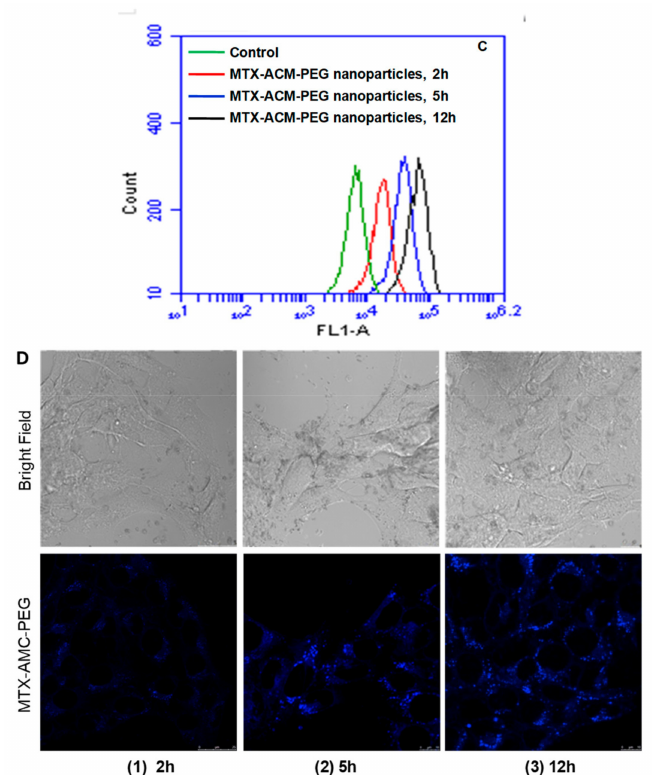
Figure 4. The cytotoxicity of MTX-AMC-PEG nanoparticles to 4T1 breast cancer cells, ( A ) cell viability of 4T1 cancer cells incubated with MTX-AMC-PEG nanoparticles for 48 h; ( B ) cell viability of 4T1 cancer cells incubated with MTX-AMC-PEG nanoparticles (0.4 µ g / mL) under 365 nm (5 W) for 0, 0.5, 1.0, 2.0, and 3.0 min. Sample 1 was the control group of blank cells with laser irradiation (without MTX-AMC-PEG nanoparticles), sample 2 was the cells with MTX-AMC-PEG nanoparticles and di ff erent time of laser irradiation; ( C ) flow cytometry profiles of 4T1 cells incubated with MTX-AMC-PEG nanoparticles for 2 h, 5 h, and 12 h; ( D ) confocal laser scanning microscopy images of 4T1 cells incubated with MTX-AMC-PEG nanoparticles for 2 h, 5 h, and 12